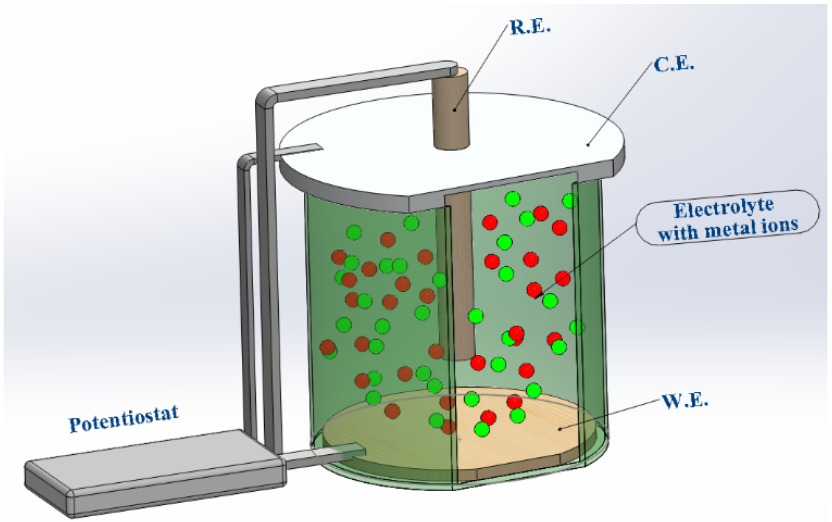
Figure 2. Schematic diagram of the experimental setup. The electrolyte contained different positive and negative metal ions: Co 2+ , Pt 2+ , Fe 2+ , Ni 2+ , Cl − , HO −